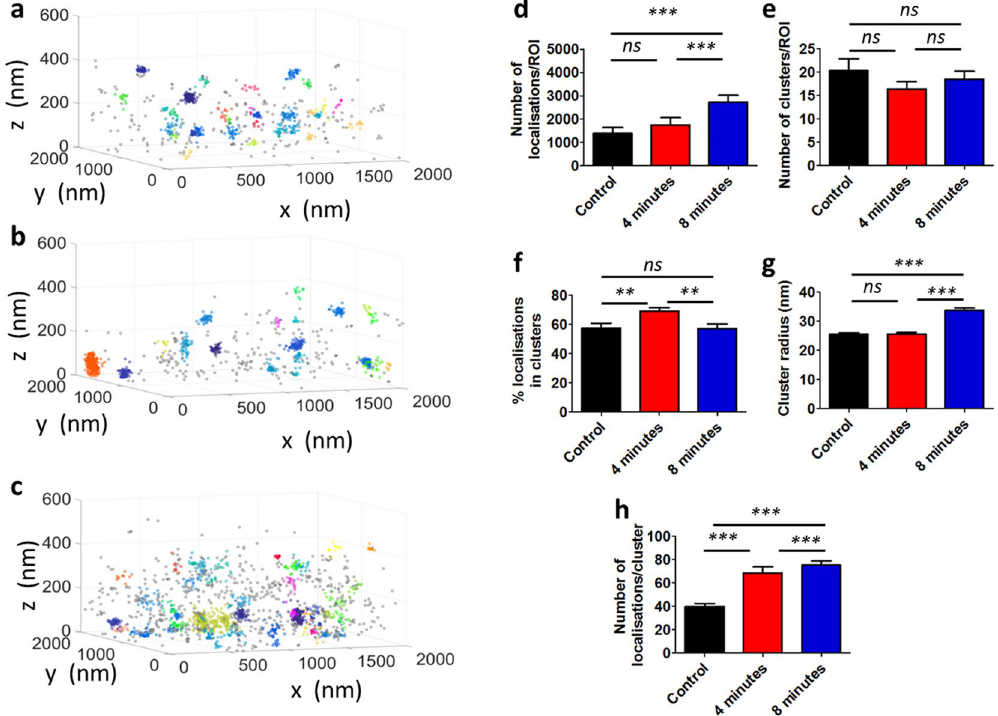
Figure 3. 3D Bayesian cluster analysis of iPALM data of the distribution of LAT at the T cell immunological synapse. Representative cluster maps of LAT-mEos3.2 ( a ) in non-activated T cells, ( b ) in T cell synapses fixed after 4 mins, ( c ) in T cell synapses fixed after 8 mins. For each condition, ( d ) total number of localisations per ROI, ( e ) number of detected clusters per ROI, ( f ) percentage of localisations in clusters for each ROI, ( g ) cluster radii and ( h ) number of localisations per cluster. Bars represent mean values and S.E.M. ns = not significant, * p ≤ 0.01, ** p ≤ 0.001, *** p ≤ 0.0001, Mann-Whitney U